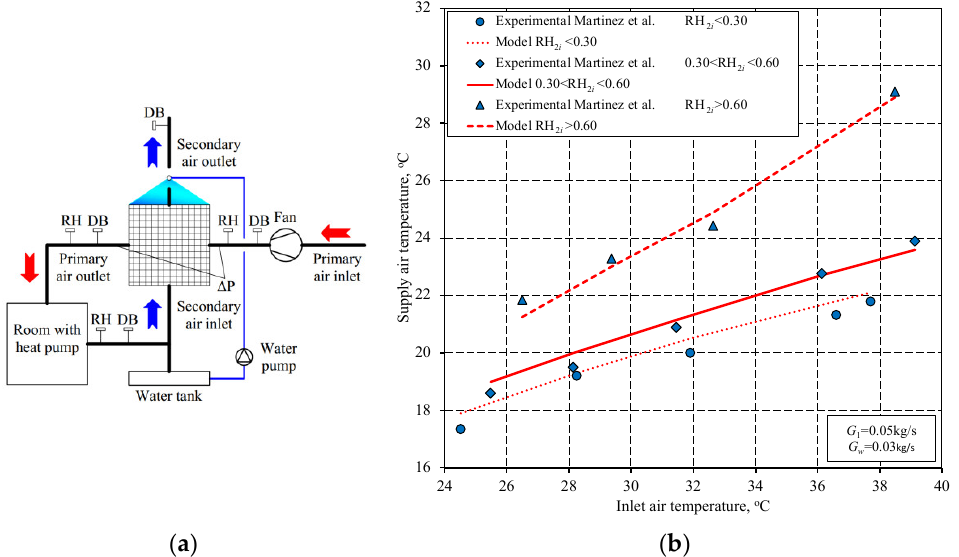
Figure A3. Validation of the cross-flow indirect cooler to existing data from the literature. ( a ) Scheme of the testing bench in the study performed by Martinez et al. [25]. ( b ) Supply air temperature obtained from the mathematical model and the experimental data.